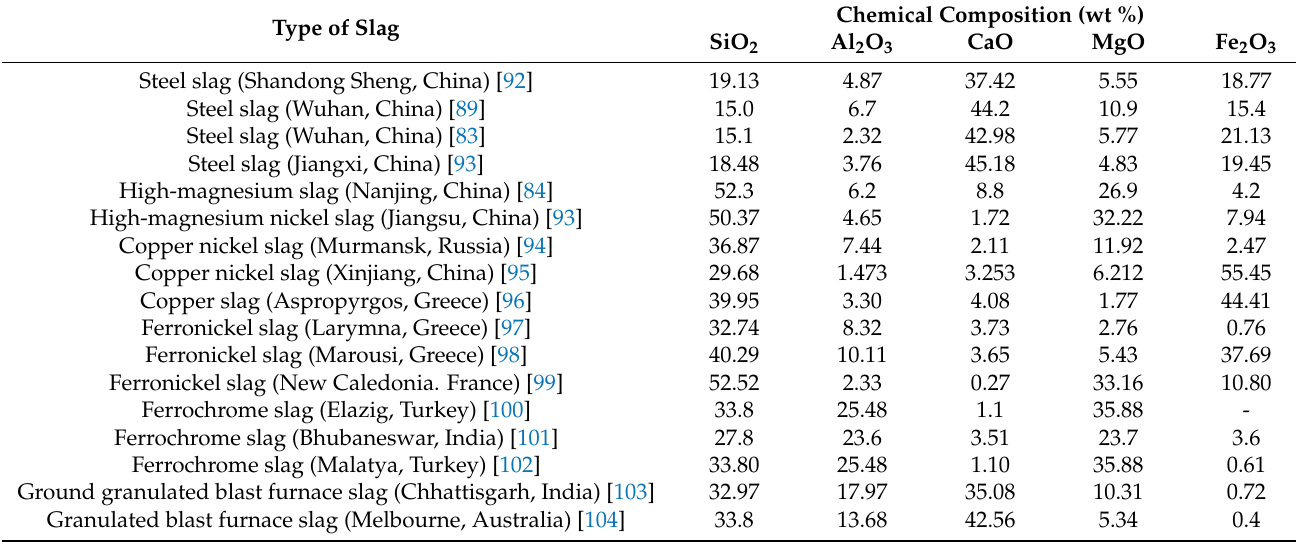
Table 6. Chemical composition of slag from different region and